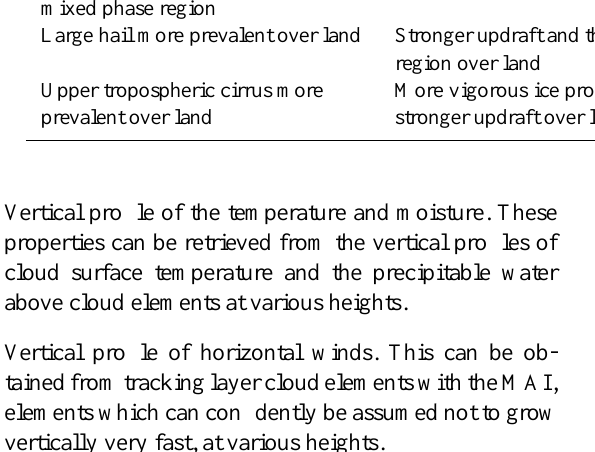
Table 2. Contrast in land–ocean behavior in moist convection. Phenomenon Thermodynamic Explanation Aerosol Explanation “Warm rain” convection more prevalent over ocean Lightning activity more prevalent over land mixed phase region Large hail more prevalent over land Stronger updraft and thinner warm rain Upper tropospheric cirrus more prevalent over land